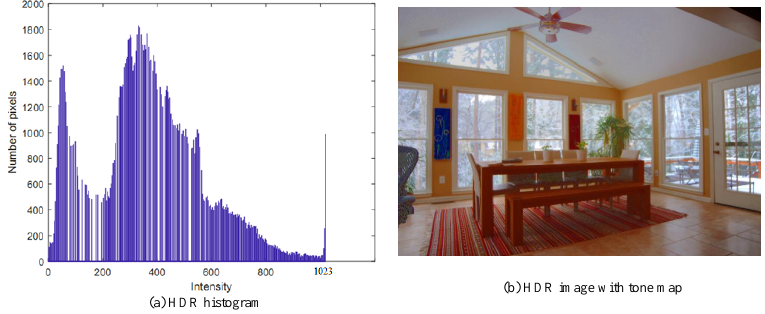
Figure 9. Histogram of HDR intensity image and the HDR image with